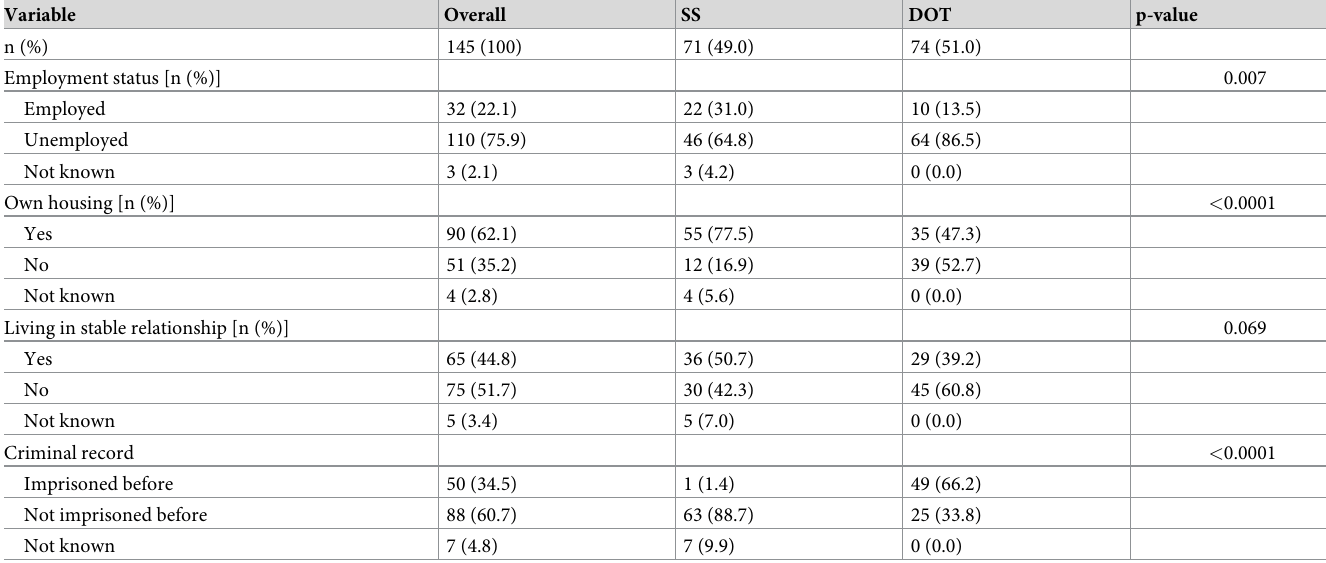
Table 2. Socioeconomic characteristics of study patients at